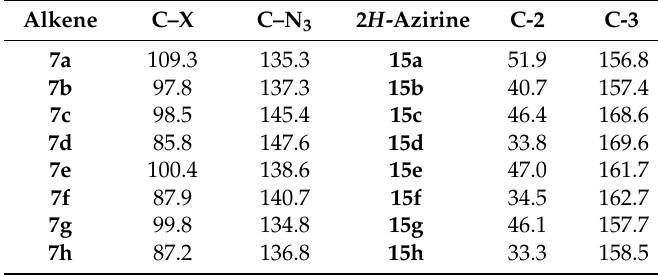
Table 2. 13 C NMR in CDCl 3 of the haloazidoalkenes 7 and 2 H -Azirines 15 ( δ in ppm).